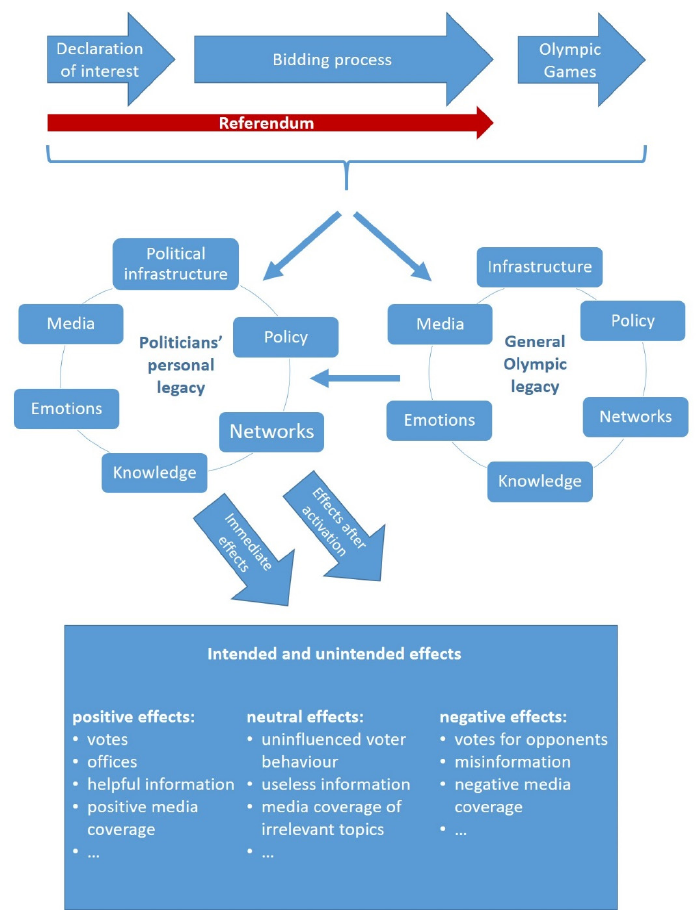
Figure 3. Sources and effects of politicians’ personal legacies from Olympic bidding processes, Olympic referenda, and Games.